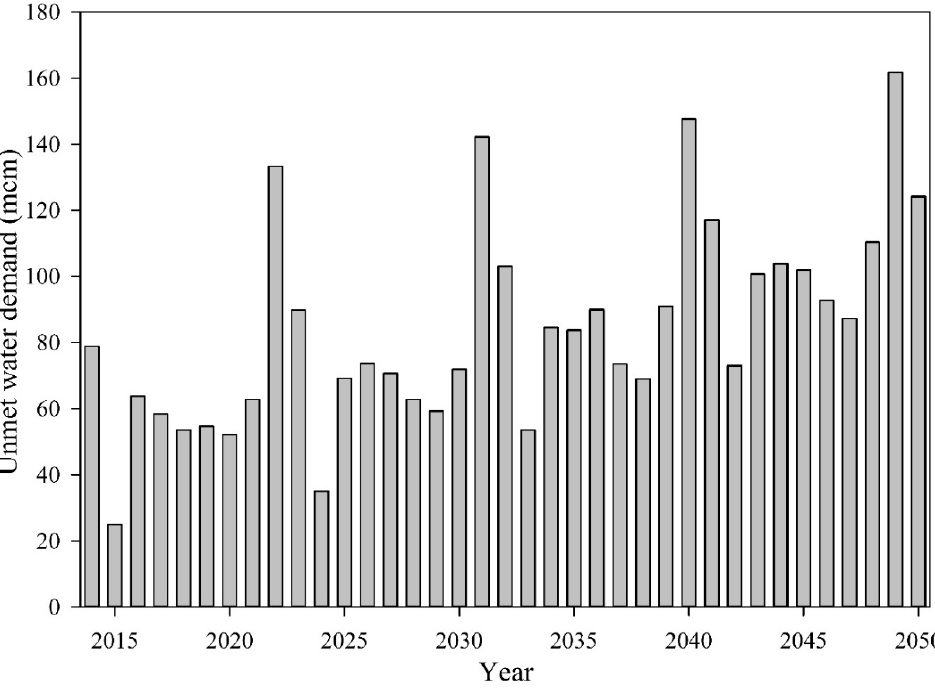
Figure 10. The unmet water demand for the reference/business as usual (2014–2050) scenario in the Upper Indus Basin (UIB).